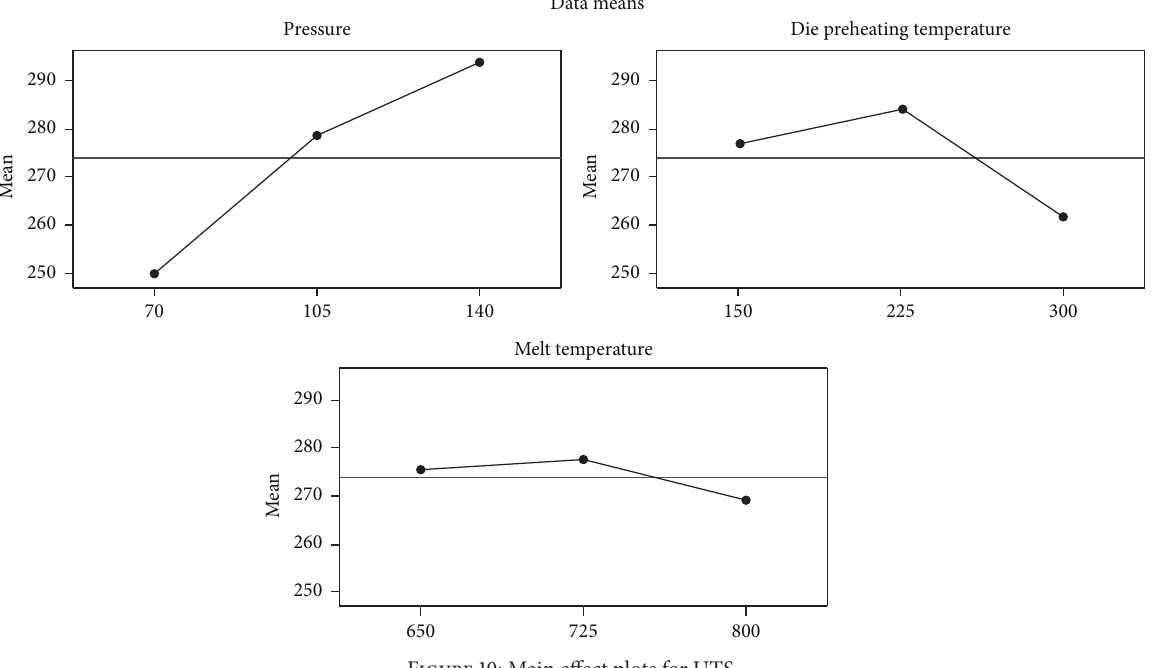
Figure 10: Main effect plots for